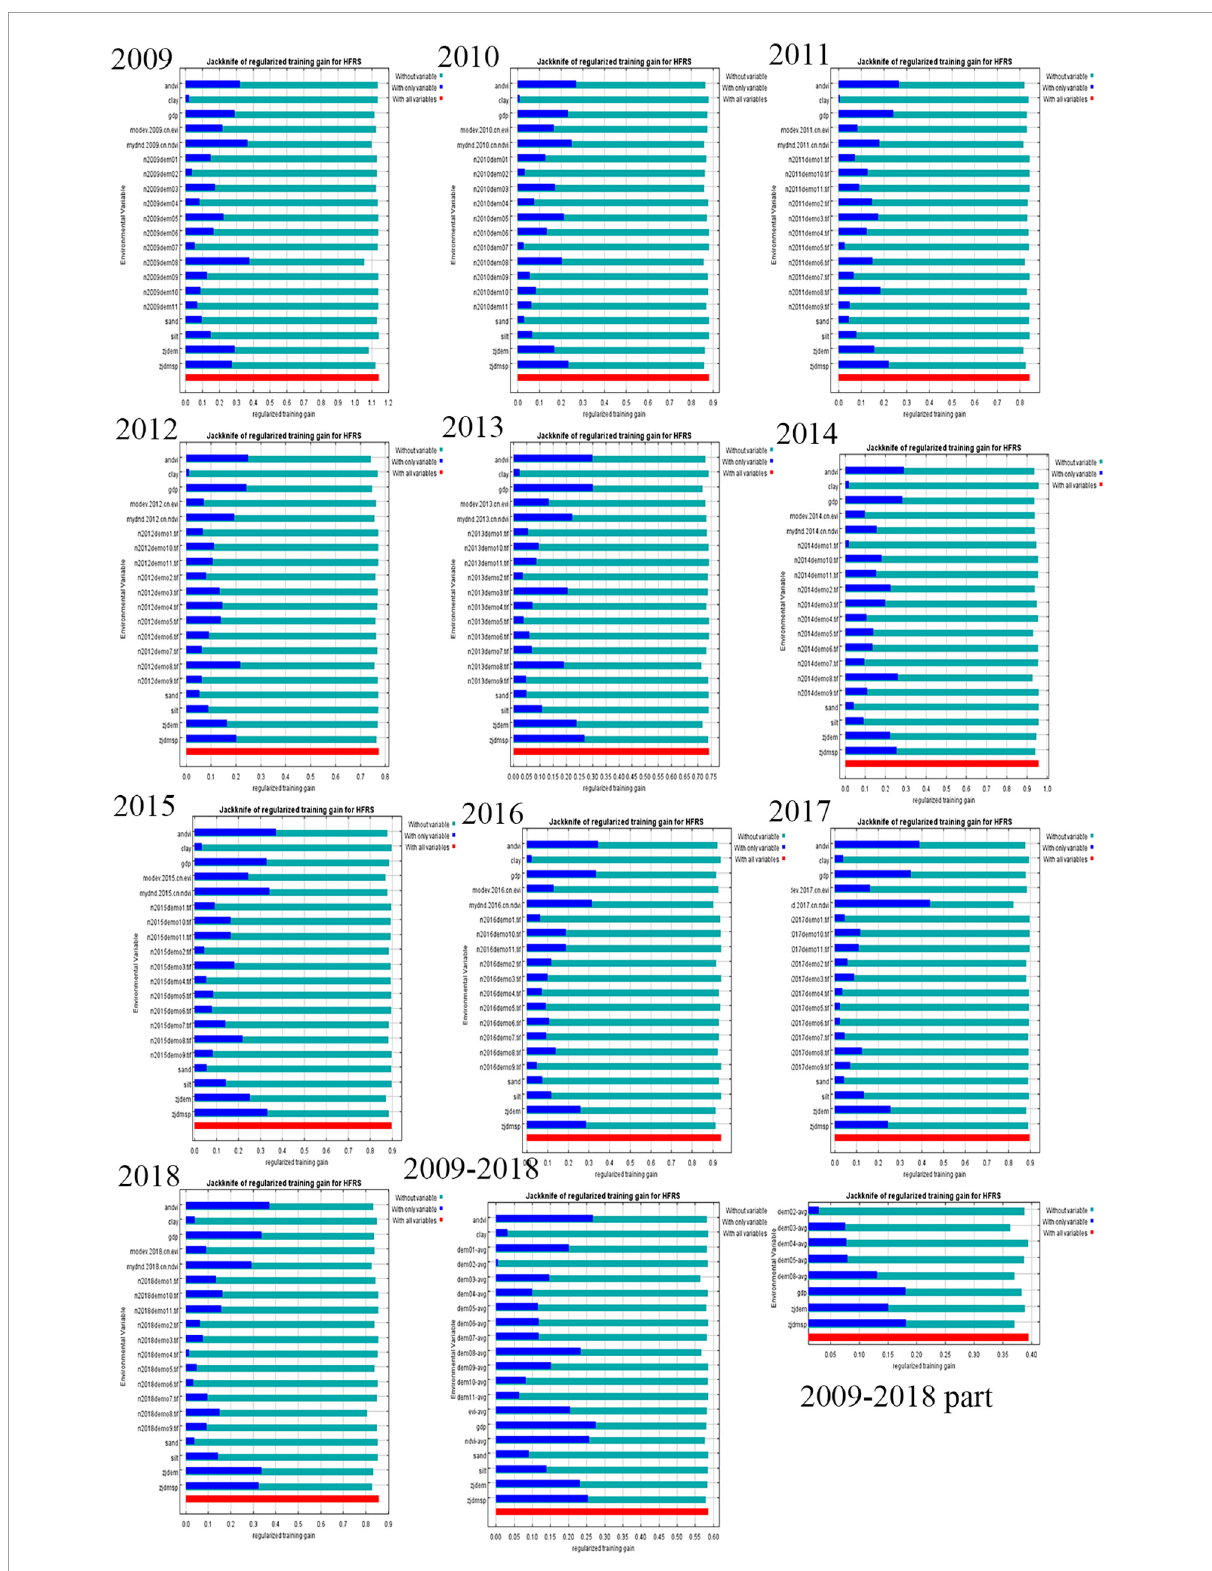
FIGURE3 The results of the jackknife test of variable